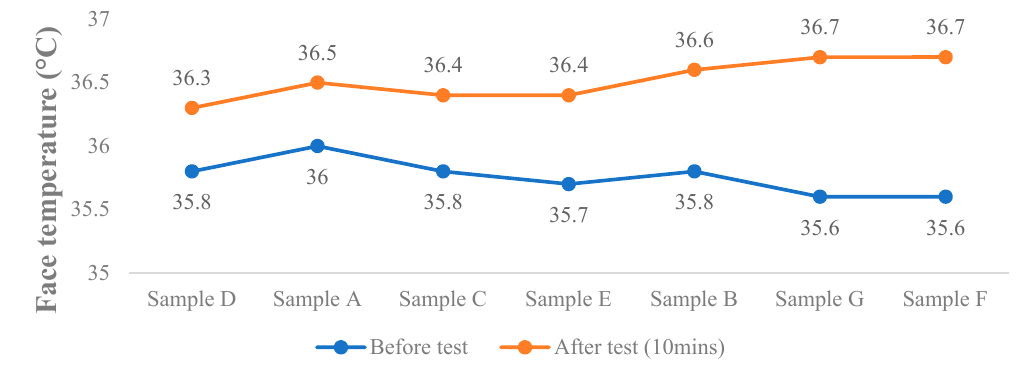
Figure 5. Recorded face temperature di ff erence, in-mask temperature and in-mask humidity of di ff erent masks in the wear trial. Note: In-mask temp. ( ◦ C): Simple D = 32.5; Simple A = 34.2; Simple C = 33.1; Simple E = 34.5; Sample B = 34.1; Sample G = 34; Sample F = 34.2. In-mask humidity